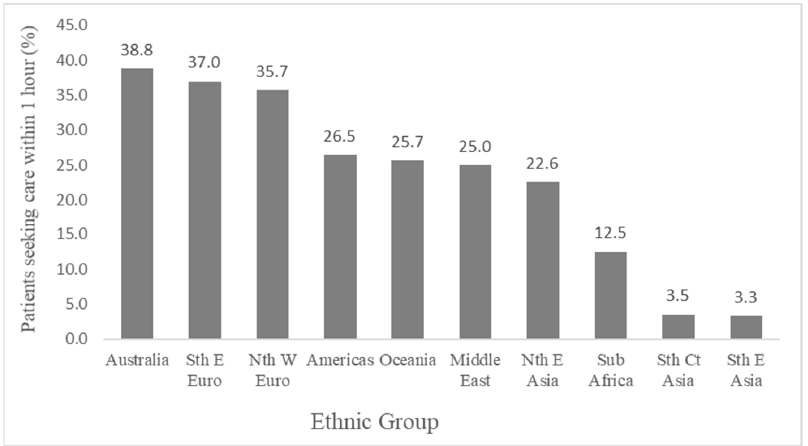
Figure 3. Comparisons of proportion of patients seeking care for chest pain within one hour between ethnic and Australian ‐ born groups.